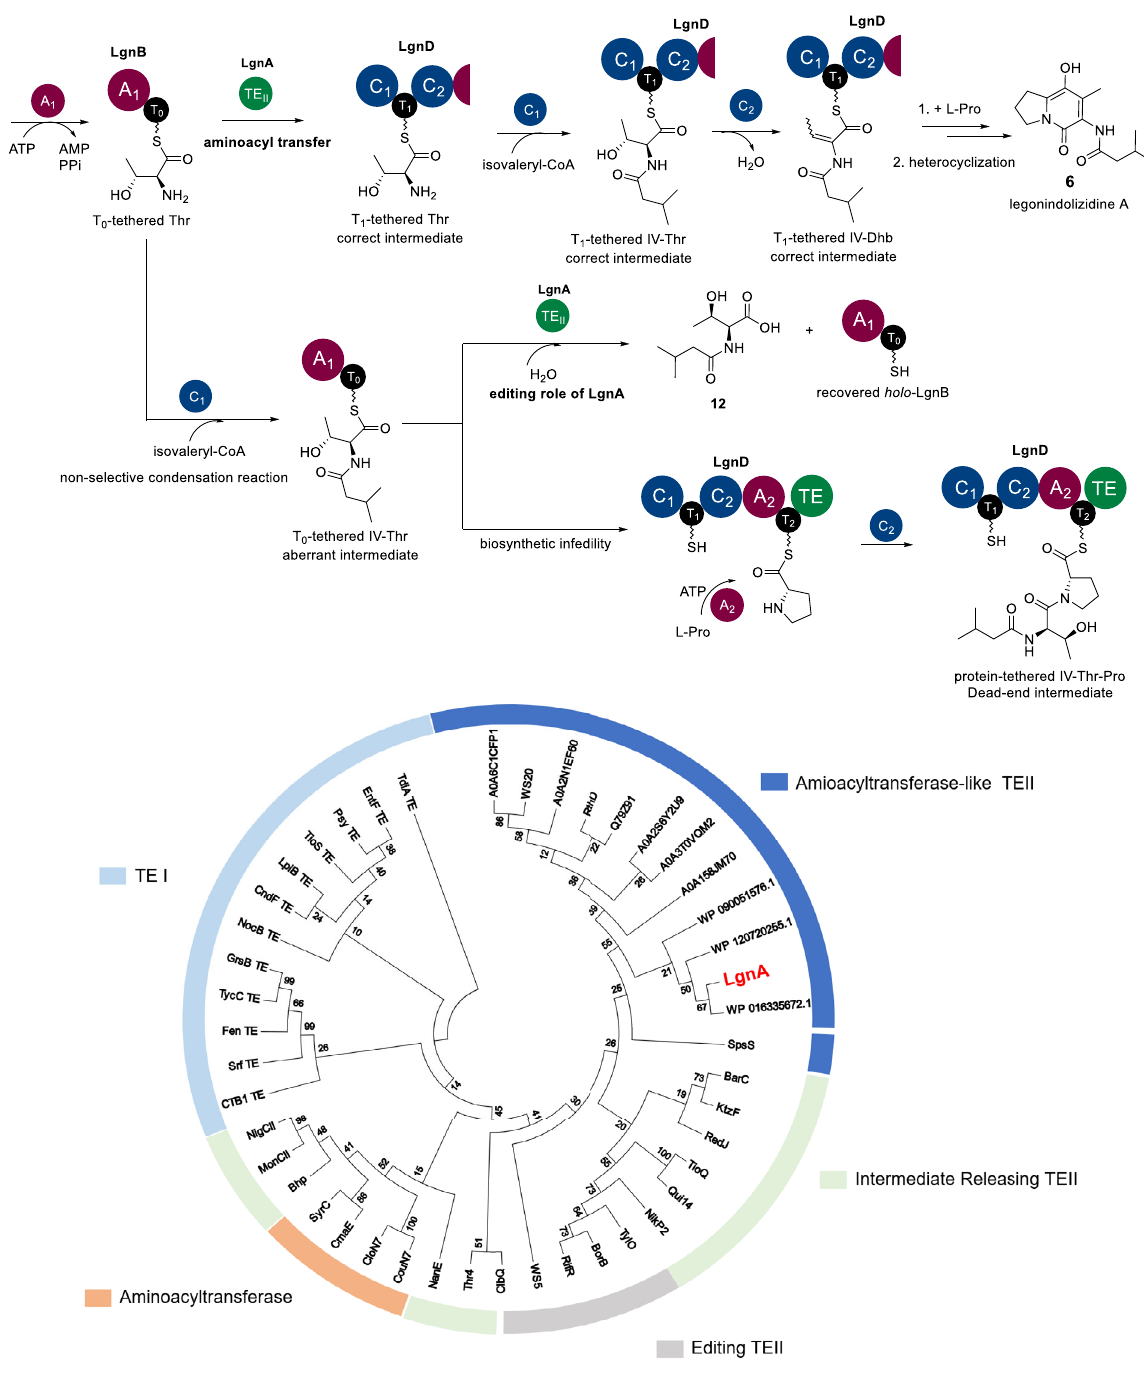
Fig. 5 Overview of the essential role of the bifunctional TE II , LgnA, in the legonindolizidine A 6 NRPS assembly line. a LgnA catalyses L-Thr unit transaminoacylation reaction between LgnB-T 0 and LgnD-T 1 domain. The correct intermediate, LgnD-T 1 -bound L-Thr, undergoes the fi rst condensation with IV-CoA to yield LgnD-T 1 -bound IV-Thr, followed by the C 2 -catalysed dehydration on L-Thr residue to provide LgnD-T 1 -tethered IV-Dhb for the downstream pathway. Due to the nonselective condensation reaction, LgnB-T 0 -bound L-Thr reacts with IV-CoA to generate the aberrant intermediate, LgnB-T 0 -bound IV-Thr. LgnA plays the editing role of removing LgnD-T 0 -bound IV-Thr to regenerate the holo -LgnB. However, the nonselective condensation domain could catalyse the reaction between LgnB-T 0 -tethered IV-Thr and the downstream L-Pro unit to generate the “ dead-end ” intermediate protein-tethered IV-Thr-Pro. b Phylogenetic analysis indicates that LgnA and LgnA-like TE II CDSs form a distinct clade from typical TE II enzymes, TE I domains, and known aminoacyltransferases in NRPSs. A maximum likelihood tree containing bootstrap values was generated using MEGA 7.0.26. The sequence information for thioesterases and aminoacyltransferases used in this analysis are listed in Supplementary Table 4.